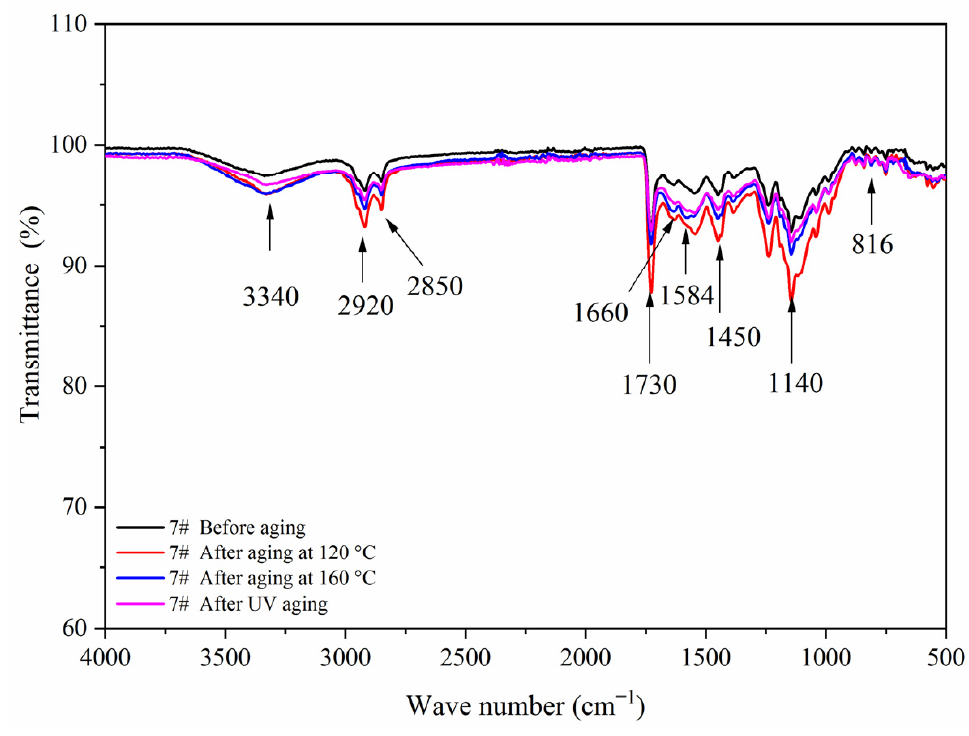
Figure 18. FTIR of sample 7# before and after aging.